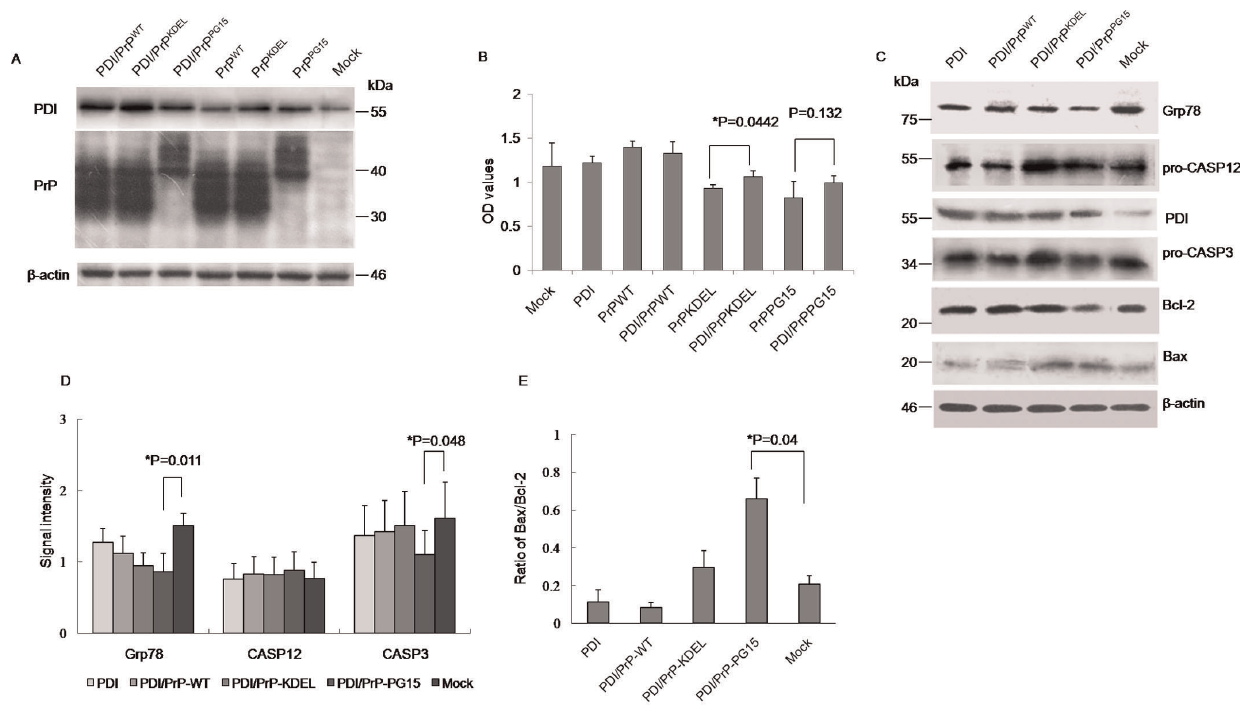
Figure 4. Influences of overexpression of PDI on PrP mutants-induced cytotoxicity and the alterations of relevant cellular factors. A. Evaluation of the influence overexpressing PDI on the expressions of various PrP constructs by Western blots. Cell lysates were separated in 15% SDS- PAGE and the specific immunolots for PDI and PrP were reacted with individual antibodies. B. Cell viabilities assayed by CCK-8 kit. Each group is assigned to three repeating parallel units and measured with a spectrophotometer under 450 nm. The results are calculated from three independent tests and indicated as mean 6 SD. Statistical differences compared with controls are illustrated as *P , 0.05. C. Western blots. Cell lysates were separated in 15% SDS-PAGE and the specific immunolots for Grp78, pro-caspase12, PDI, pro-caspase3, Bcl-2 and Bax were detected with individual antibodies. D. Quantitative analysis of each gray numerical value of Grp78, pro-caspase12, pro-caspase3 vs that of individual b -actin. The results are calculated from three independent tests and presented as mean 6 SD. Statistical differences compared with controls are illustrated. E. The relative densities of Bcl-2 and Bax specific bands normalized to b -actin are presented as ratio of Bax/Bcl-2. Statistical differences compared with controls are